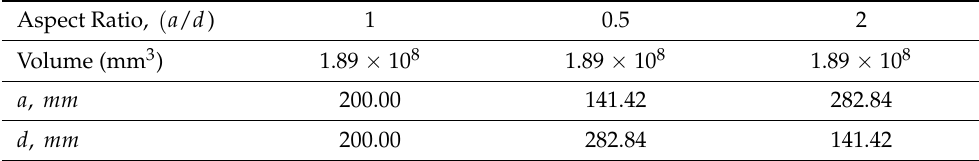
Table 4. Dimensions of the torus for aspect ratios of 1 (case F), 0.5 (case J), and 2.0 (case K). Aspect Ratio, ( a / d